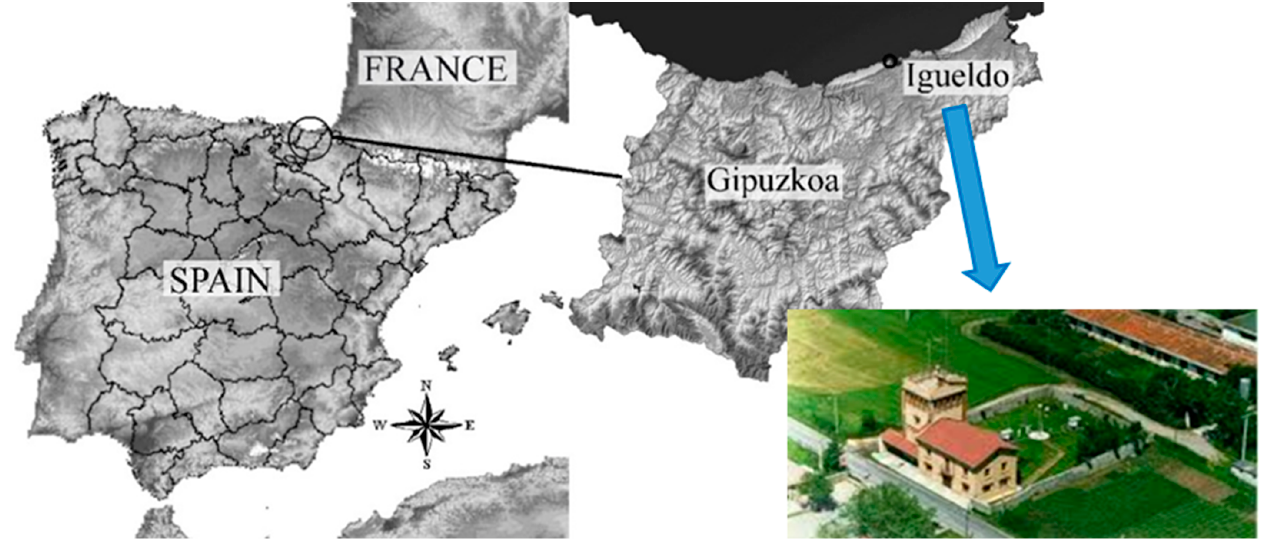
Figure 1. Location of the Igeldo weather station (Gipuzkoa).